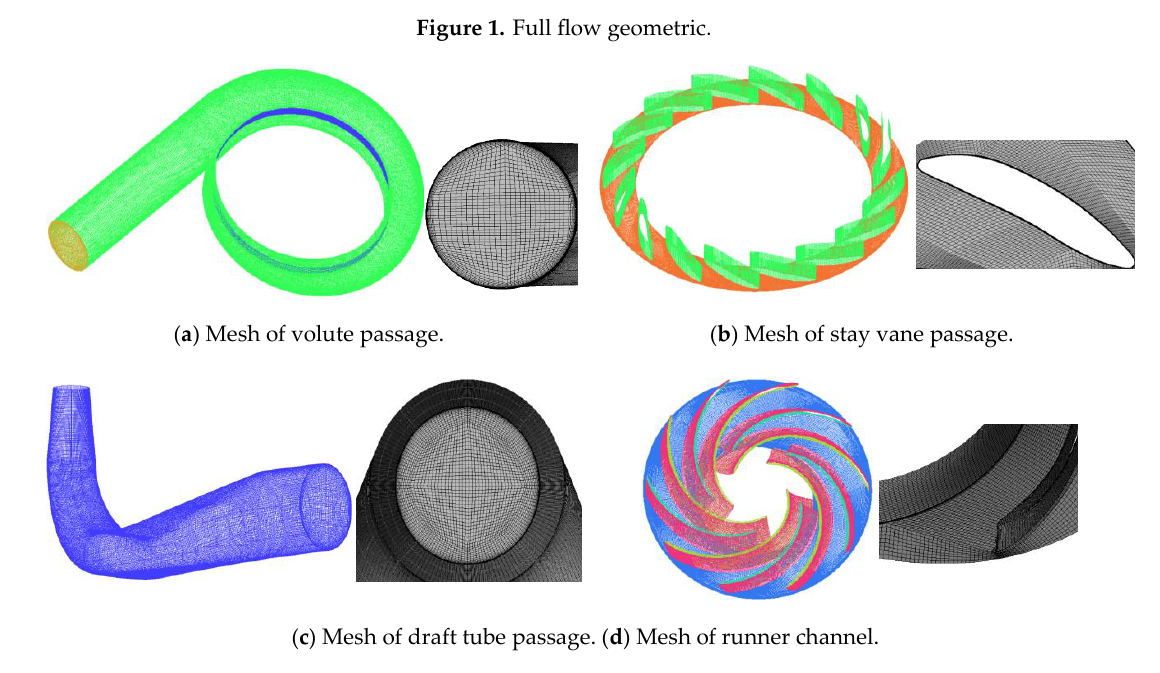
Figure 1. Full flow geometric.